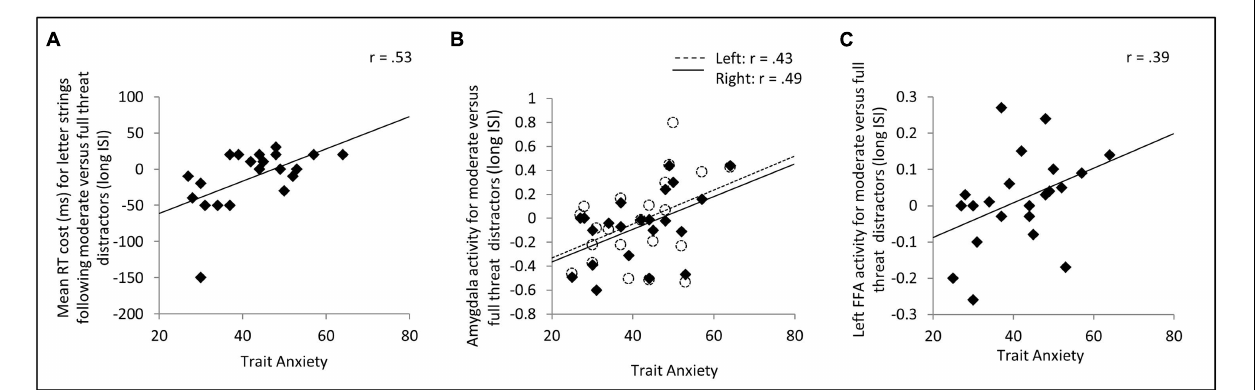
FFA (C) activity to moderate threat versus full threat distractor faces. Note. Removal of the outlier in (A) had a negligible effect on the correlation, r (18) = 0.52, p < 0.01, one-tailed. In (B) and (C) , activity refers to mean % blood oxygen level dependent (BOLD) signal change across the region of interest in question. This was modeled using a canonical hemodynamic response function. FFA, fusiform face